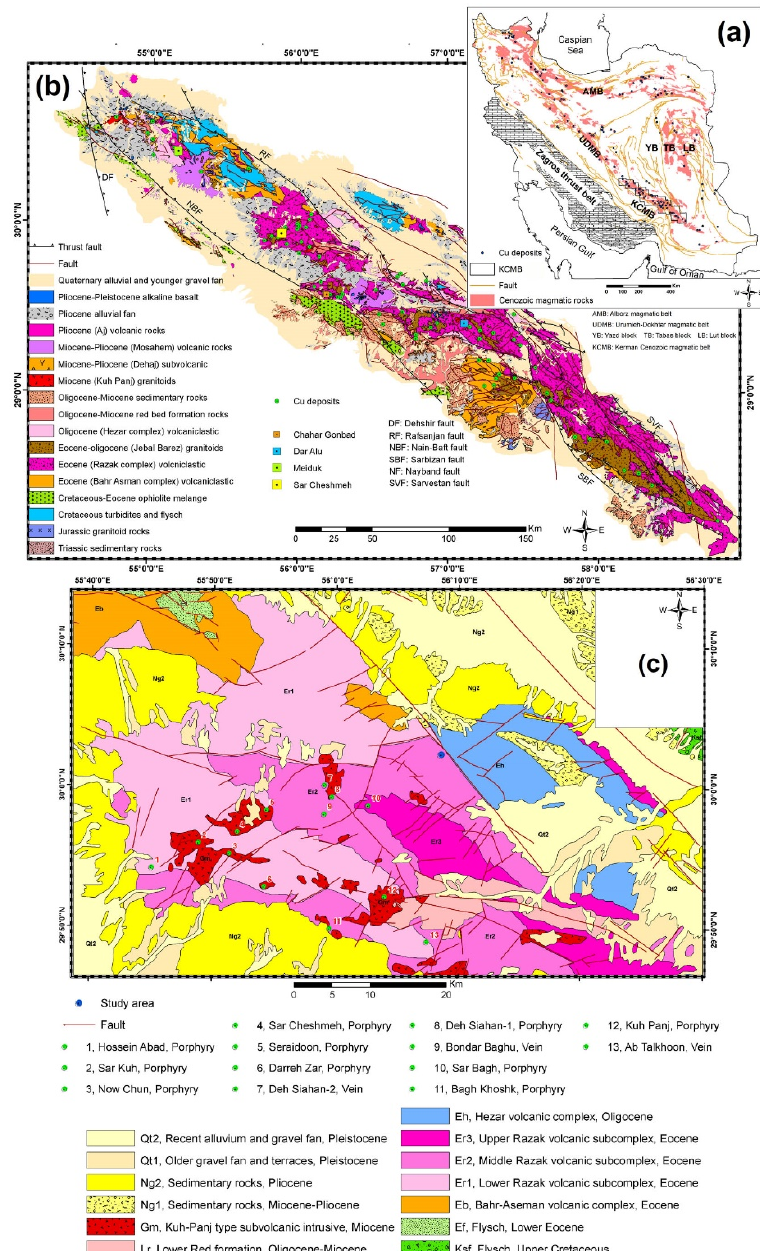
Figure 1. ( a ) Relief map of Cenozoic volcanic belts [27], ( b ) simplified geology map of the KCMB [25], and ( c ) geology map of the study area [27].